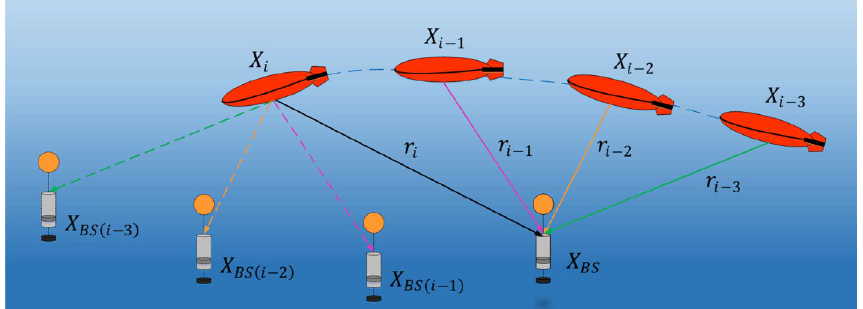
Fig. 1 Schematic diagram of ASBL positioning